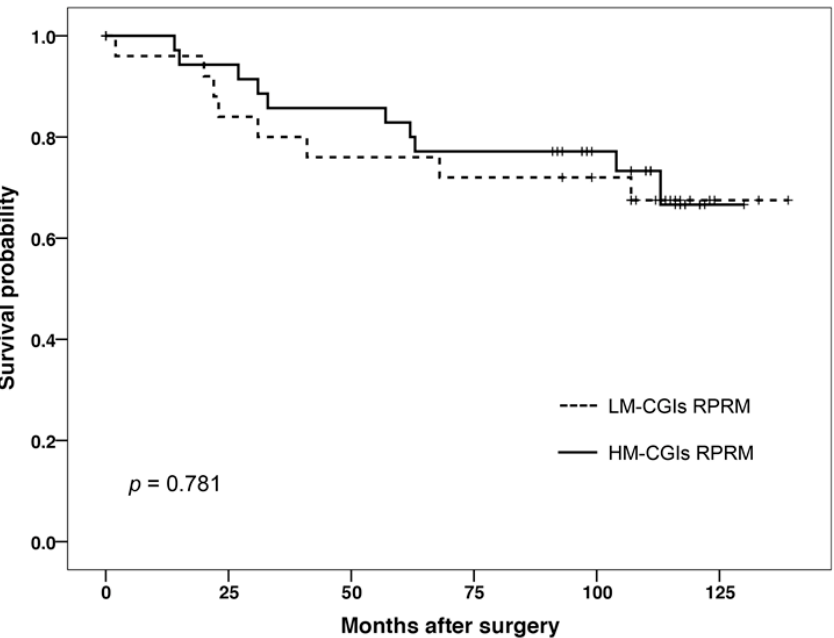
Figure 2. Kaplan–Meier survival curves of 77 breast cancer (BC) patients indicates that differential methylation of RPRM CGIs was not associated with overall survival in BC patients. Solid lines indicate patients whose tumors had a high methylation of CGIs, while the dotted line indicates those tumors with low methylation in the CGIs region.